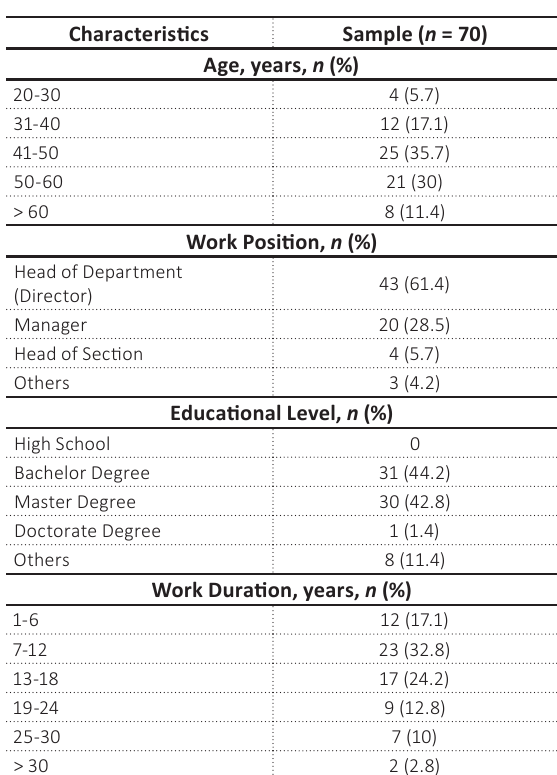
Table 1. Demographic characteristics